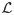
Mutual information between location (L) and measurement (M) for different encoding strategies.The figure indices A, B and C correspond to the different flow conditions (fast flow, slow flow and boundary flow); the rows 1-3 compare different encoding strategies. In the first row the mutual information is calculated based on single samples taken at either the narrow grid (blue curves correspond to blue circles in Fig 1) or the wide grid (green curves correspond to green triangles in Fig 1). A2-C2: Coding schemes with increasing number of bits assigned to two sensors. Two samples separated in space were taken at a single time. Solid lines show information using knowledge of which sample occurs in which sensor; dashed line shows information ignoring which of two sensors measures which sample. A3-C3: Assigning bits to two temporal samples taken at the same location with a delay of 1.6 s. In all panels, bold curves correspond to estimates for the locations as given in Eq (2) and shaded regions correspond to information estimates for jittered locations (see Methods).